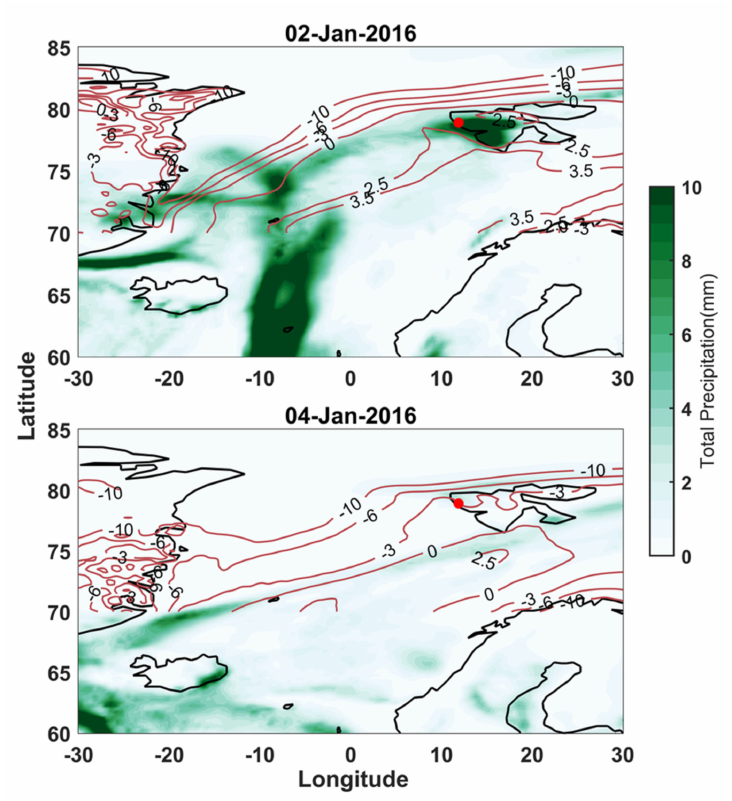
Figure 11. The ERA5 Surface air temperature overlaid on accumulated precipitation for a heavy rainy day ( top panel ) and a light rainy day ( bottom panel ). The red mark is assigned for the station